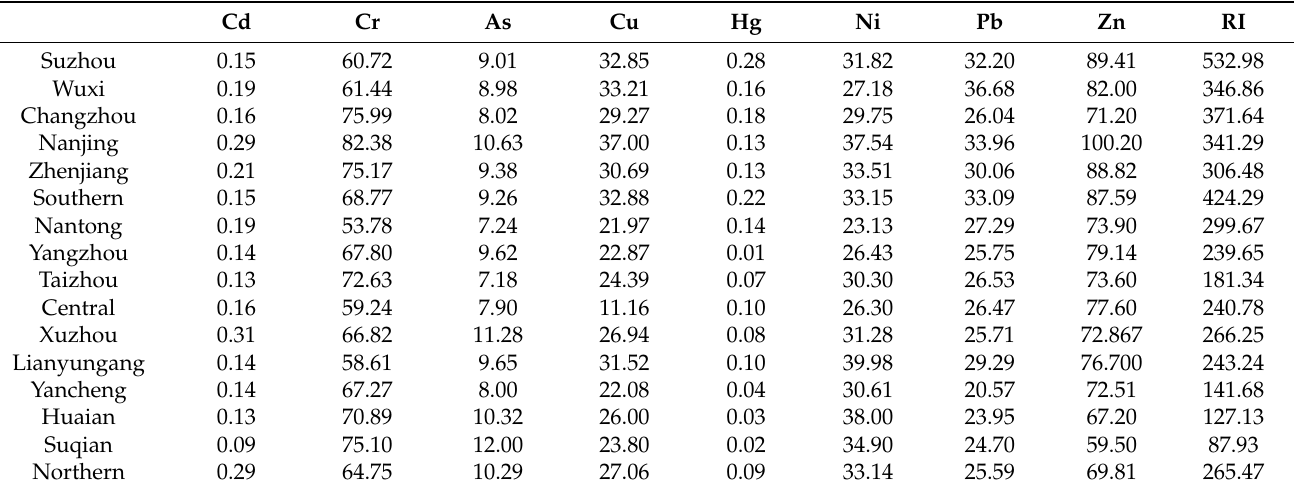
Table 2. The weighted mean values (mg/kg) and potential ecological risk indexes of heavy metals in each